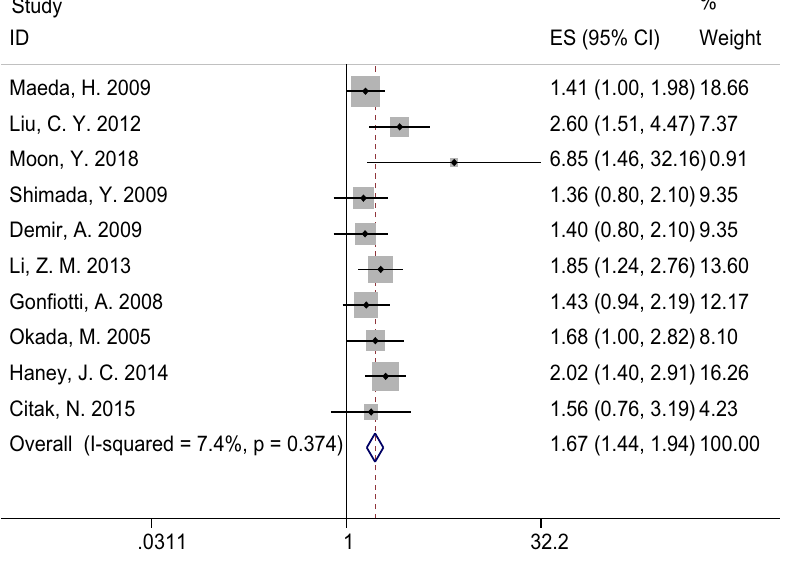
Figure 2. Forest plot of hazard ratios for overall survival of patients diagnosed with pN1 NSCLC and involved with N1h versus N1p. CI confidence interval, HR hazard ratio.